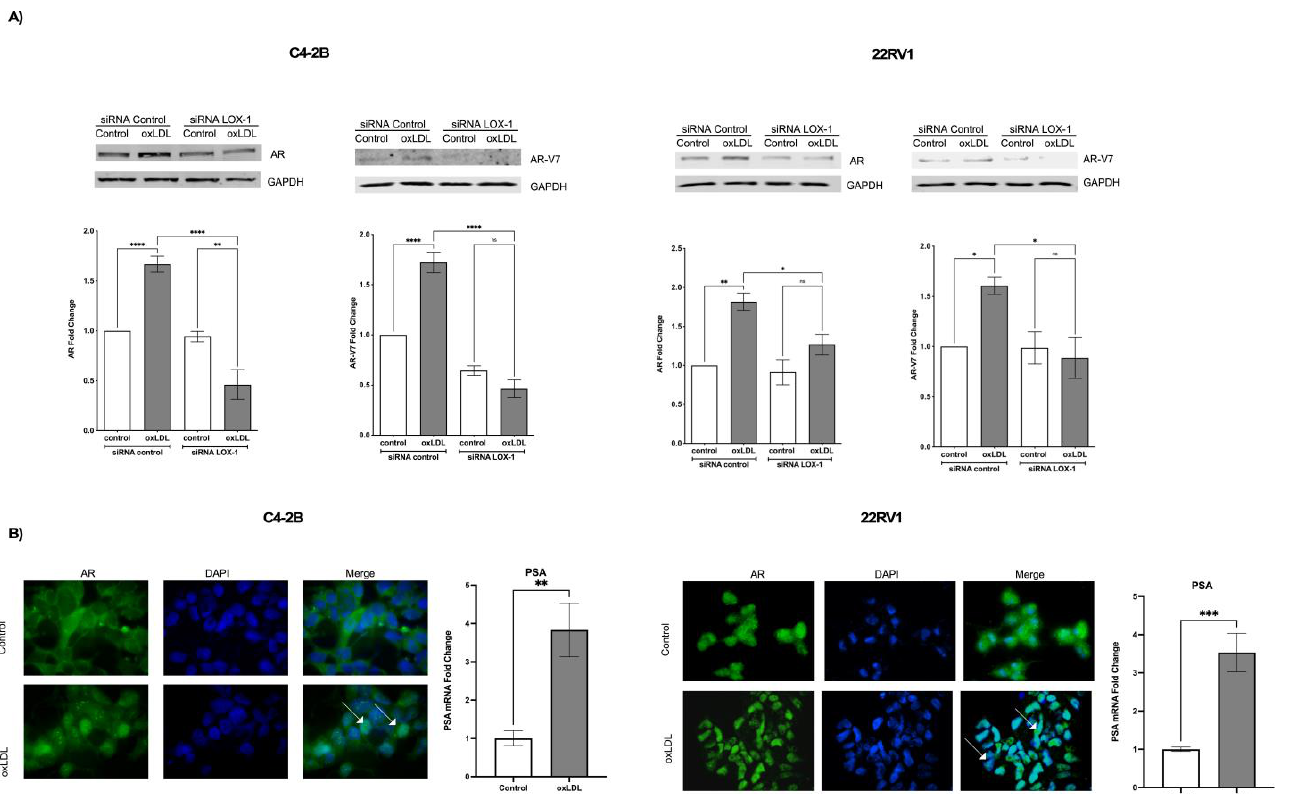
Figure 4. OxLDL/LOX-1 induces the expression of AR and AR-V7 on C4-2B and 22RV1 cells. ( A ) Western blot analysis of AR and AR-V7 in protein extracts of C4-2B and 22RV-1 cells transfected with siRNA against LOX-1 and treated with 50 µ g/mL oxLDLs for 24 h. ( B ) OxLDL promotes AR nuclear translocation and PSA mRNA expression in C4-2B and 22RV1 cells. The white arrows indicate nuclear immunodetection of AR in oxLDL-treated C4-2B or 22RV1 cells. The data represent means ± S.D. of three independent experiments analyzed by one-way analysis of variance and Dun- nett ’ s post-test o t -test for PSA expression analysis (**** p ≤ 0.0001, *** p ≤ 0.001, ** p ≤ 0.01, * p ≤ 0.05 , ns: non-significant statistical difference).